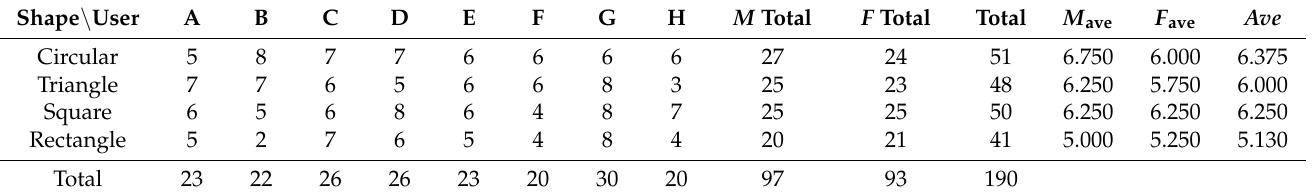
Table 2. The table of the number of correct identification of which actuators were inflated. Scores were assigned based on an eight-point scale.